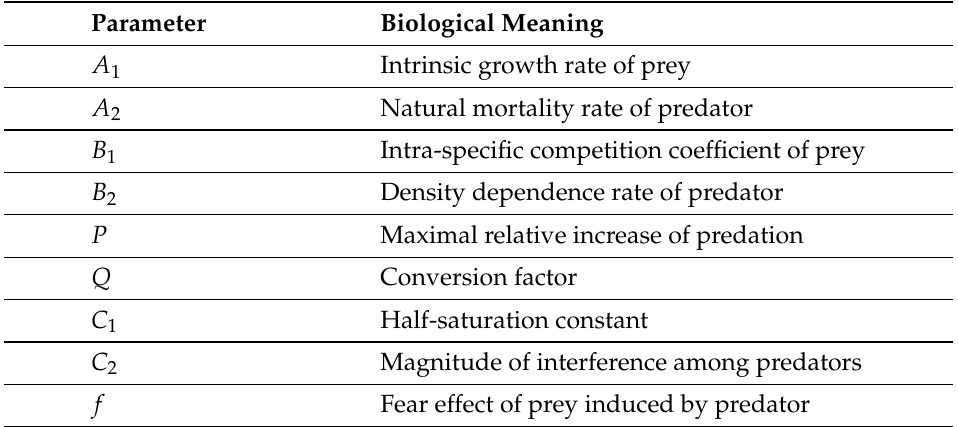
Table 1. Biological meanings of all